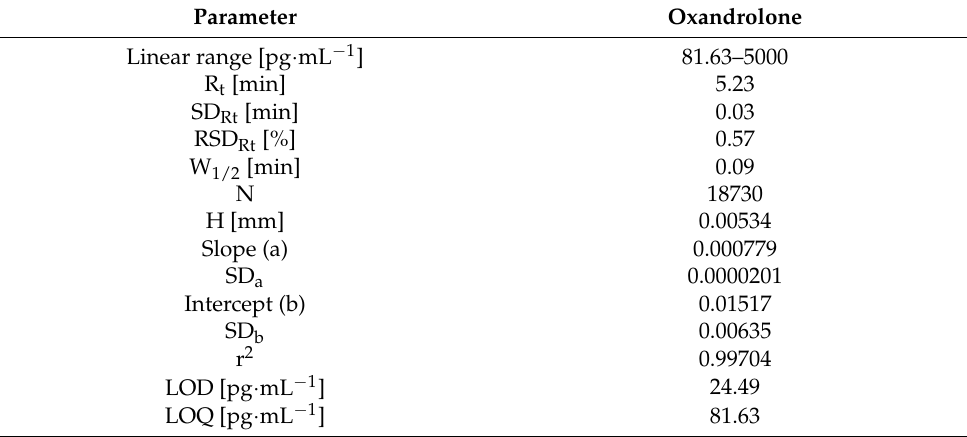
Figure 4. Representative chromatograms of oxandrolone (OXA) and methandienone as IS illustrating a real biomedical application of the SPE-UHPLC-MS/MS method. ( A ) Blank urine spiked with IS; ( B ) blank urine spiked with standard OXA (100 pg · mL − 1 ) and IS, ( C ) urine sample taken 48 h after administration of one tablet (Oxandrix (DMX laboratories), 10 mg declared content per tablet) (OXA, Rt = 5.22 min; 17-epi-OXA, Rt = 5.70 min), ( D ) urine sample taken 9 days after the administration (OXA, Rt = 5.20 min). MRM transition 307.3 → 271.2 for OXA and 17-epi-oxandrolone, and 301.3 → 149.2 for IS were used. Table 2. Calibration and selected performance parameters of SPE-UHPLC-MS/MS (QQQ) method for